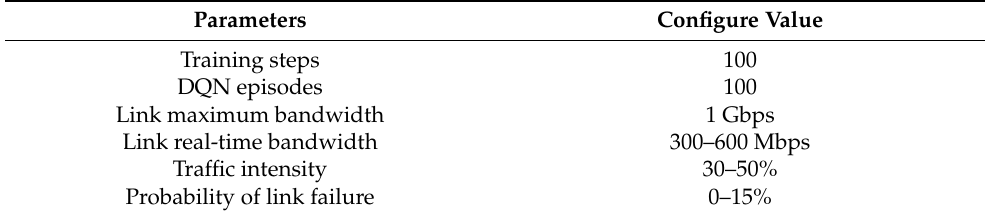
Table 3. Parameters of network topology simulation.